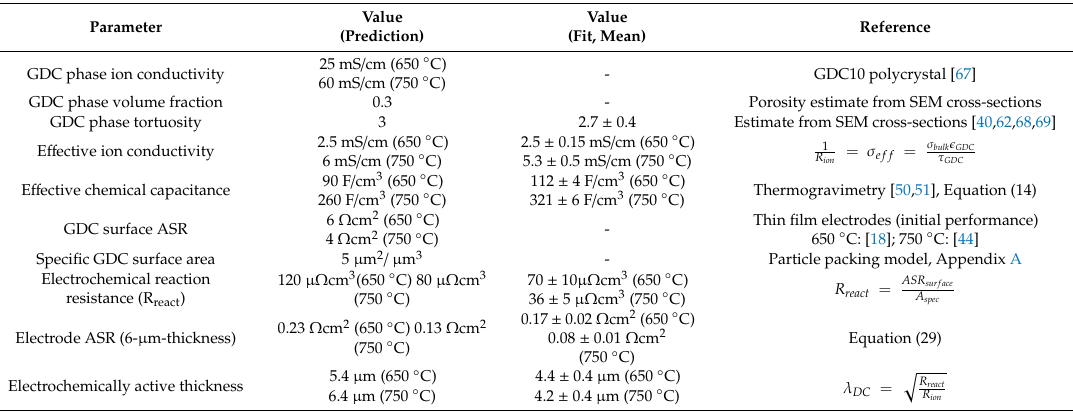
Table 2. Microstructural and electrochemical electrode parameters used for impedance prediction, and average results from equivalent circuit fitting.